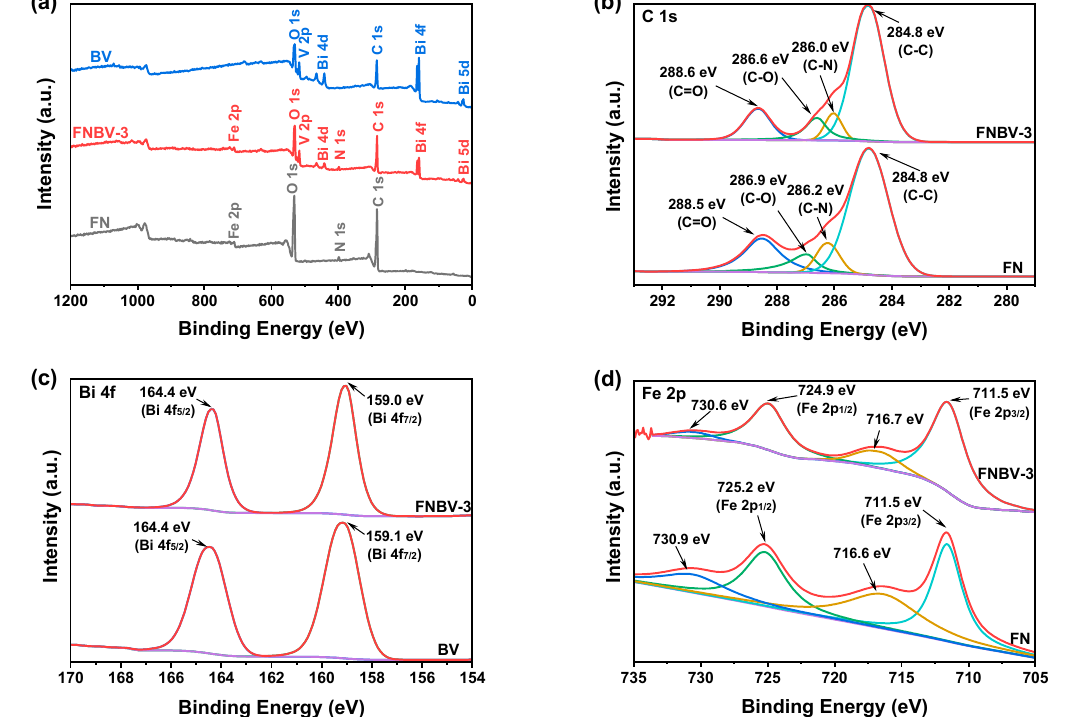
Figure 2. XPS spectra of BV, FN, and FNBV–3 samples: ( a ) survey scan; ( b ) C 1s; ( c ) Bi 4f; ( d ) Fe 2p spectra.